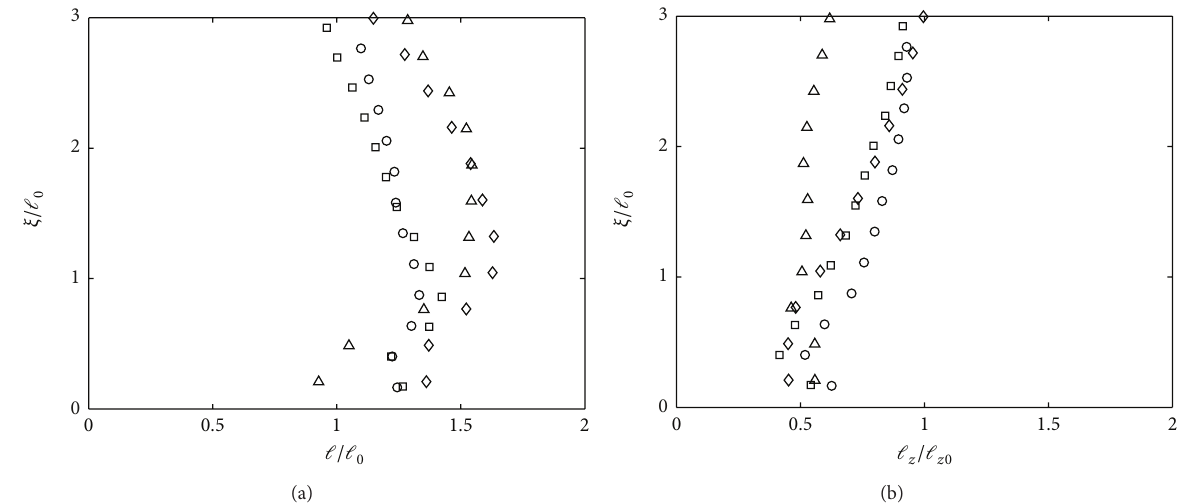
Figure 8: Plots of (a) horizontal ( ℓ ) and vertical ( ℓ 𝑧 ) integral length scales against dimensionless distance above the tank base 𝜉/ℓ 0 for < 117 . The data shown correspond to 𝑅𝑒 𝑅𝑒 𝑙